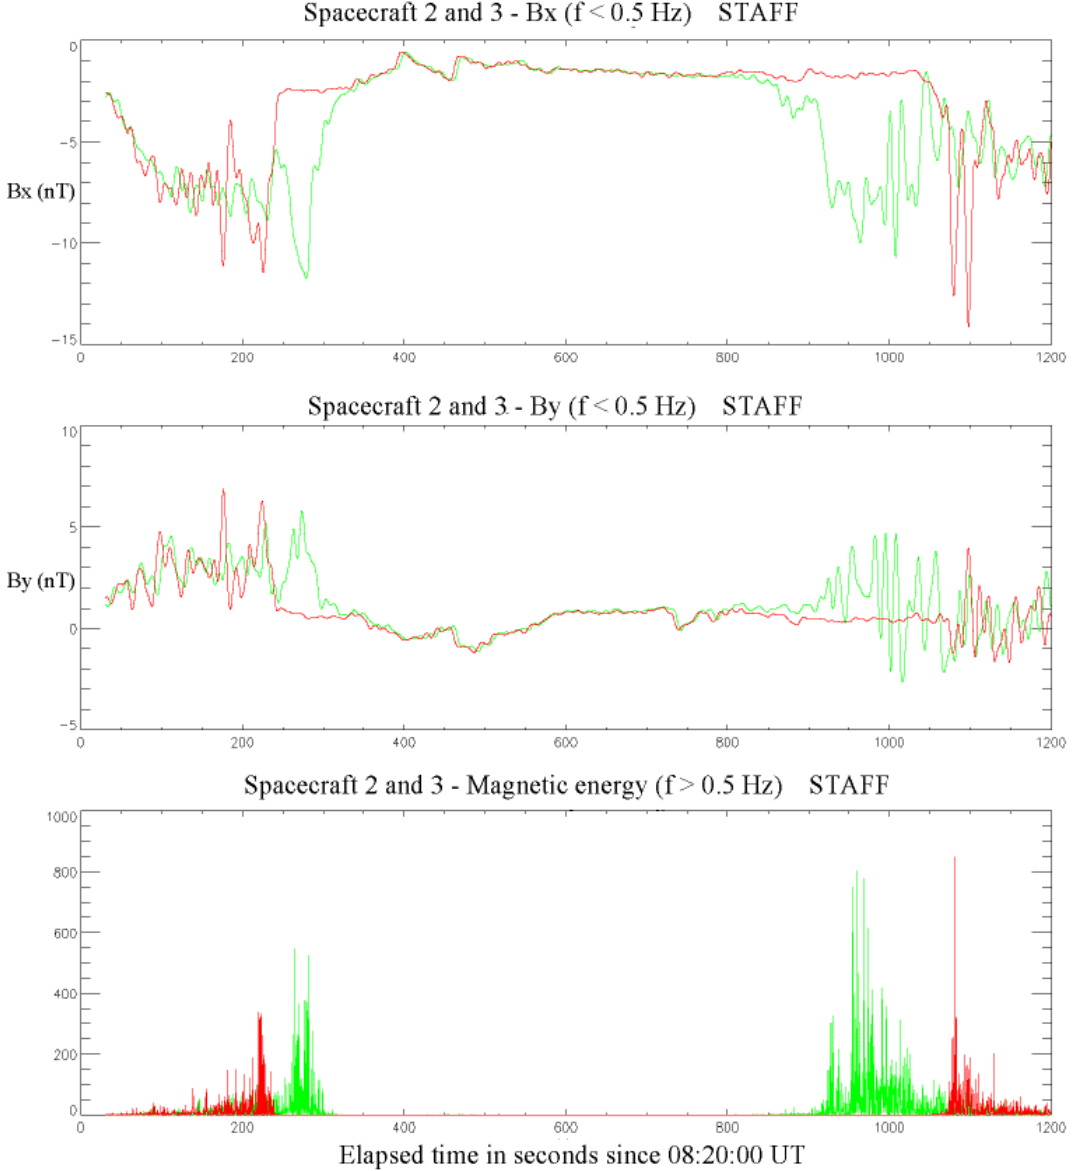
Fig. 10. Details of the Fig. 9 event. The 2 top panels give the “low” frequency parts ( f < 0.5Hz) of the waveforms of the magnetic components perpendicular to the spin axis for spacecraft 2 (red curves) and 3 (green curves): they include the DC magnetic components perpendicular to the spin axes. The bottom frame displays the magnetic energy of the high frequency part of the three magnetic components (i.e. in the frequency range 0.5 to 12.5Hz); its vertical axis is labelled in nT 2 . Horizontal axes are labelled by the number of elapsed seconds since